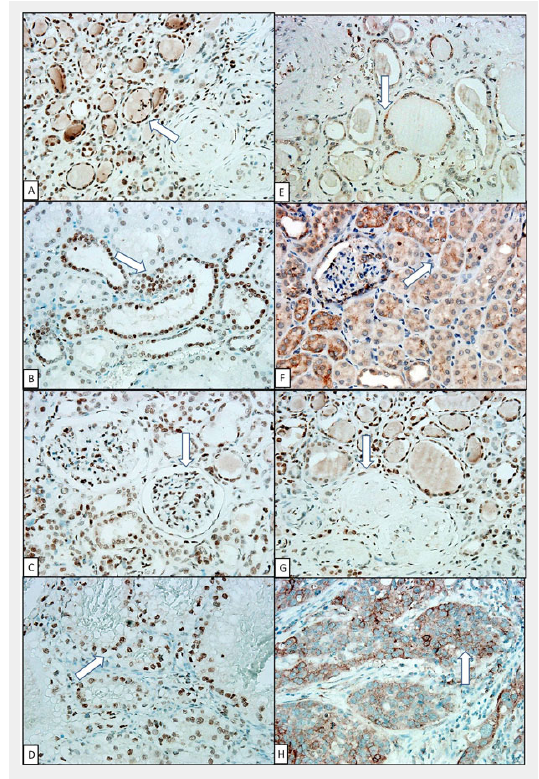
Figure 1 High expression of 8-OHdG in (A) atrophic tubular nucleus; (B) normal tubular nucleus; (C) normal glomerular nucleus; low expression of 8-OHdG in (E) atrophic tubular cytoplasm; (F) normal tubular cytoplasm; (G) sclerotic glomerular nucleus (negative control); and 8-OHdG expression in RCC nucleus (D) and UCC cytoplasm (H) (positive control). (Arrow indicated the area of 8-OHdG expression) (IHC stain,